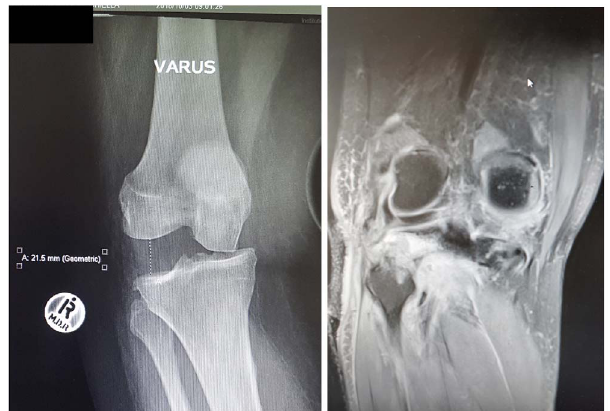
Figure 1. Imaging in a patient with a suspected MLKI. Left: AP varus stress radiograph shows a large lateral joint gap indicative of a complete disruption of the LCL, associated disruption of cruciate ligaments should be suspected. Right: The injury can also be seen on coronal T2 MRI with disruption of the posterolateral